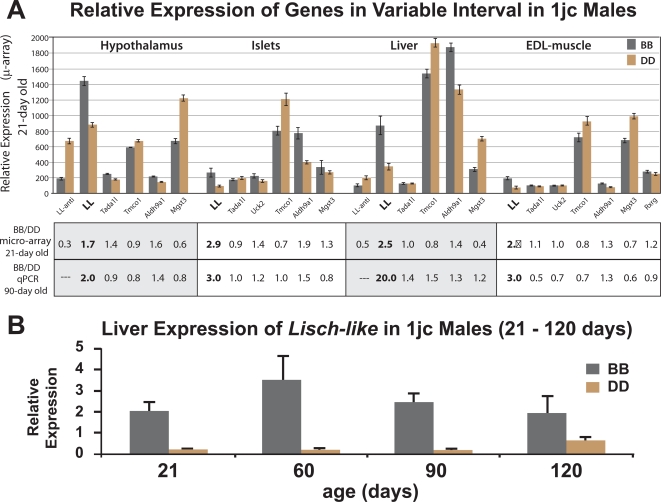
Expression Analysis of Candidate Genes and Liver Expression of Lisch-like.A) Tissue-specific expression analysis of genes in the “variable” portion of the minimum congenic interval. Data for relative expression (B/B to D/D) from Table 1 for hypothalamus, islets, liver and EDL-muscle are displayed graphically and numerically below the graph. 21-day old DD and BB Lepob/ob 1jc congenic males were analyzed using Affymetrix #430A microarrays. B) Liver expression of Lisch-like in 1jc B/B and D/D males from 21–120 days. Samples from Lepob/ob 1jc males were analyzed by qPCR.